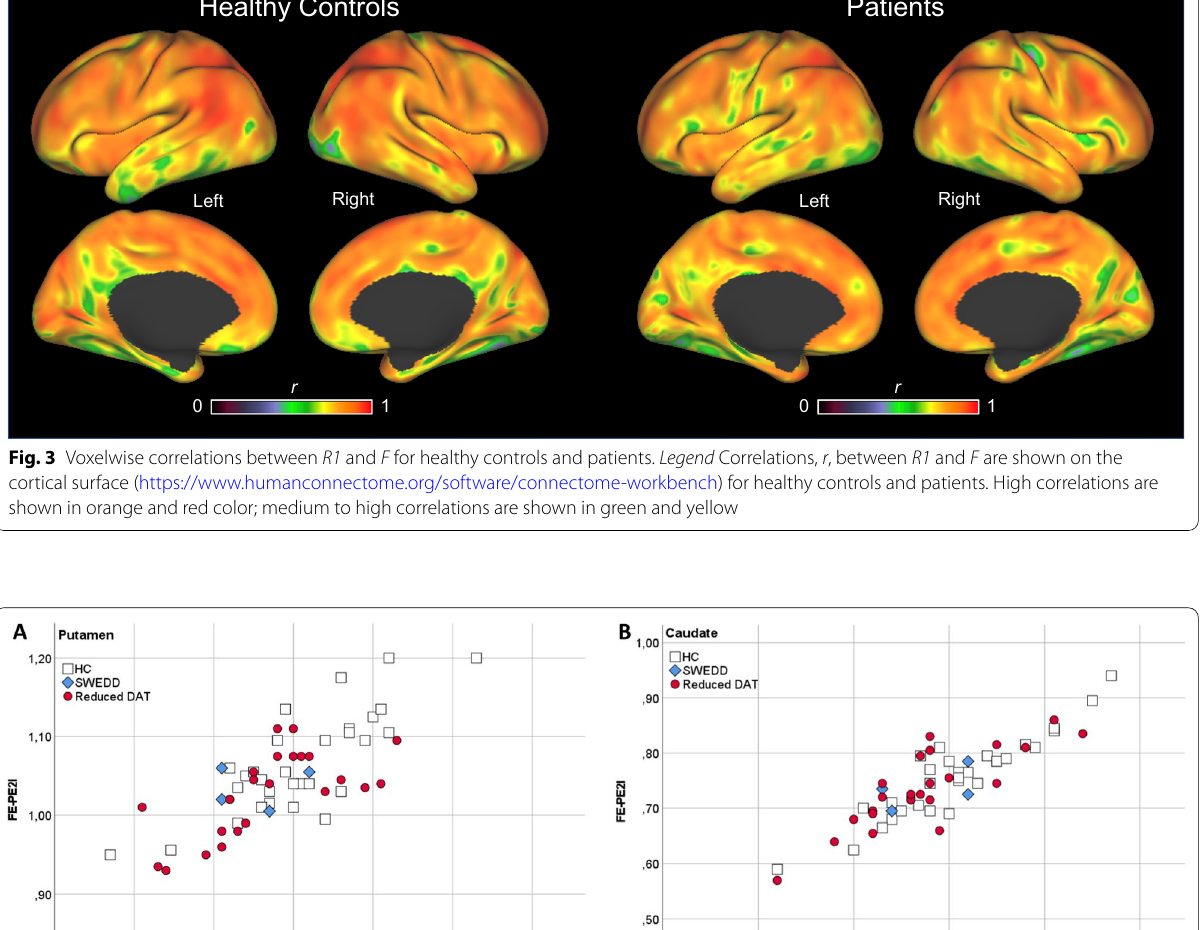
Regional measures are averaged over the left and right hemispheres. *** p < 0.001